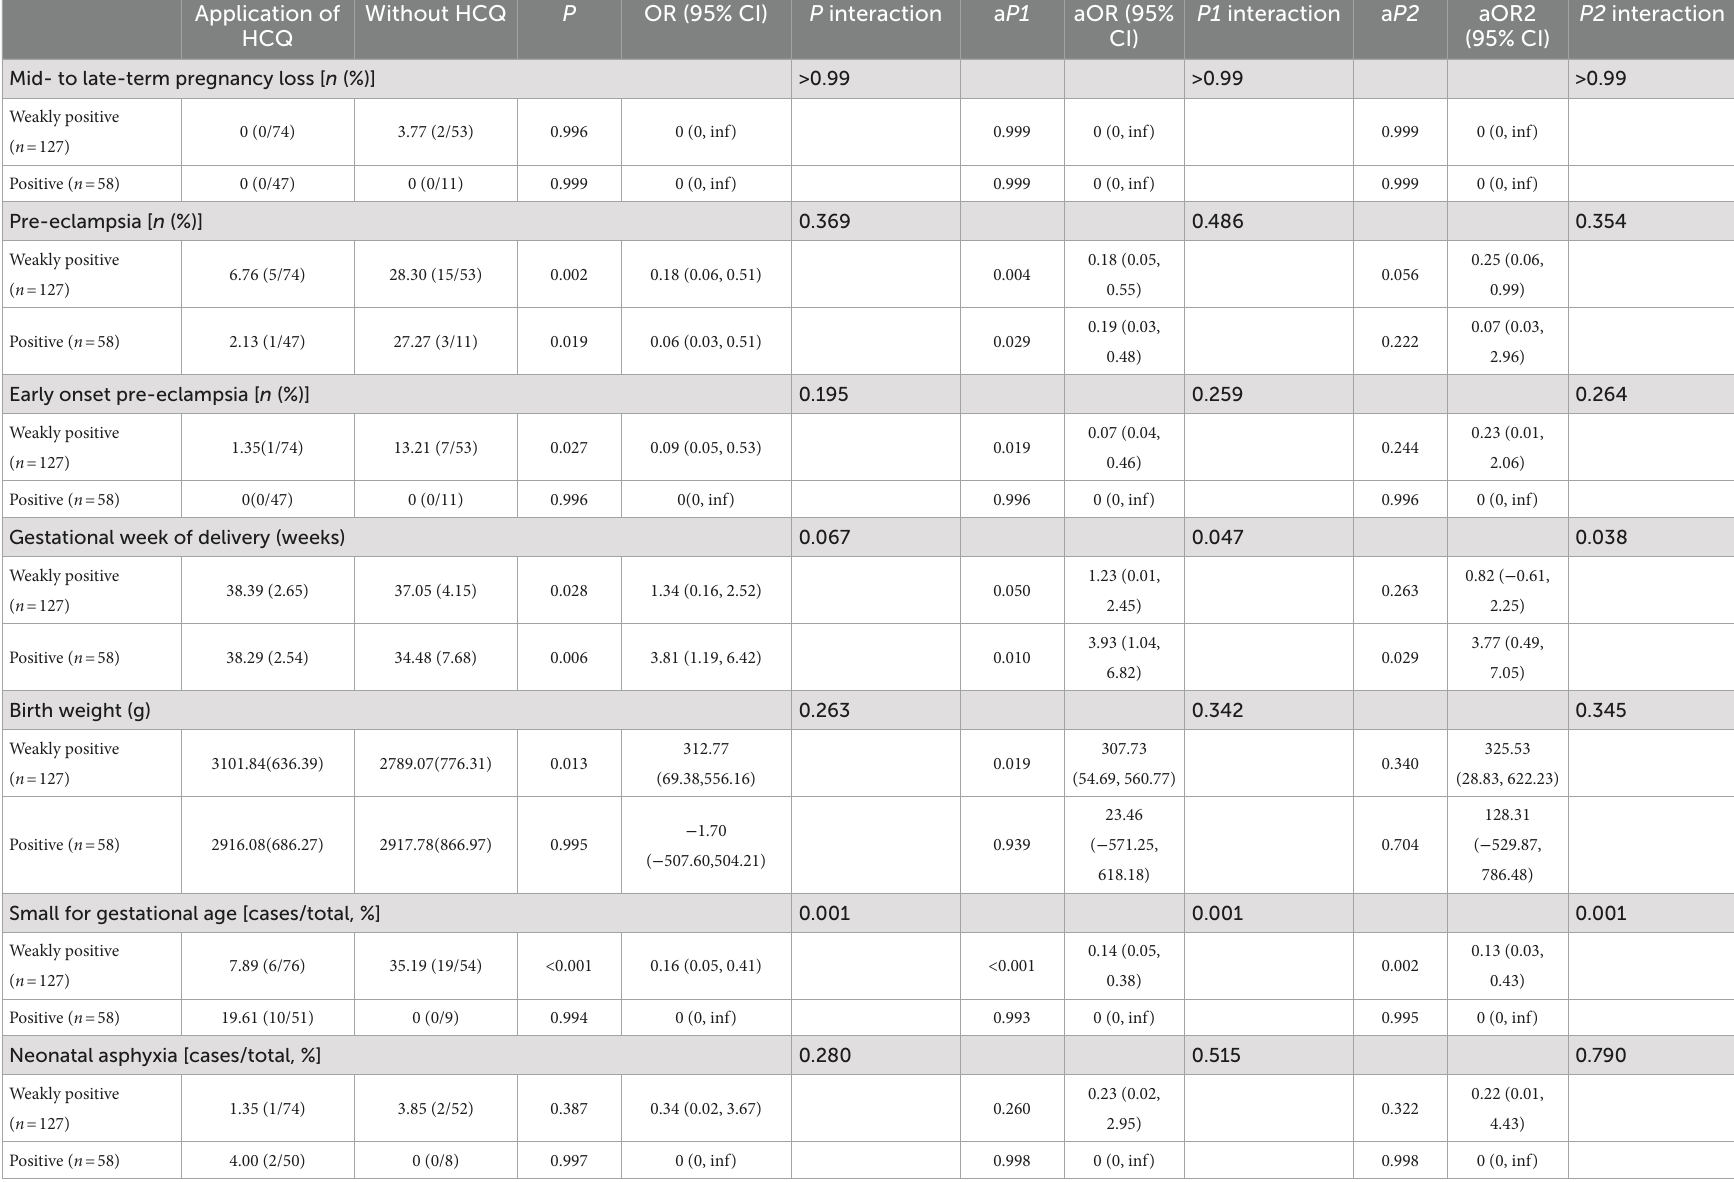
TABLE 4 Stratified analysis of hydroxychloroquine and pregnancy outcomes in antinuclear antibody positive population. Application of Without HCQ P OR (95% CI) P interaction a HCQ